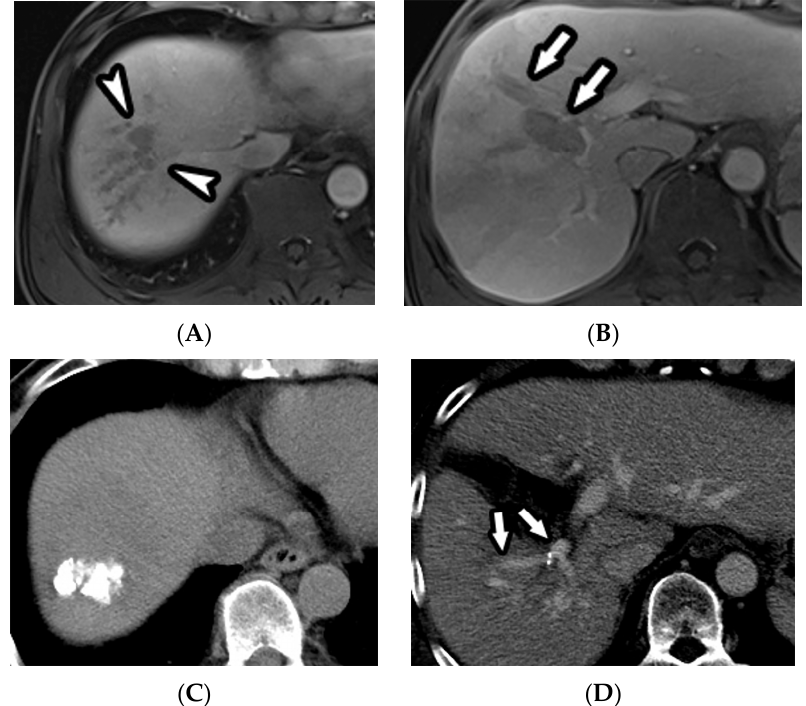
Figure 2. ( A ) A 51-year-old male patient with HCC and lobar PVTT. ( A , B ) Contrast-enhanced axial MRI images in the venous phase show a small HCC (3.4 cm maximum diameter, arrowheads) with right lobar PVTT (arrows). ( C , D ) Six months after TACE plus RT and additional TACE, non-contrast enhanced ( C ) and contrast-enhanced axial CT ( D , in the venous phase) images show a compact lipiodol uptake in the tumor ( C ) and disappearance of the right lobar PVTT ( D , arrows), with a decrease in volume of the right hemiliver.